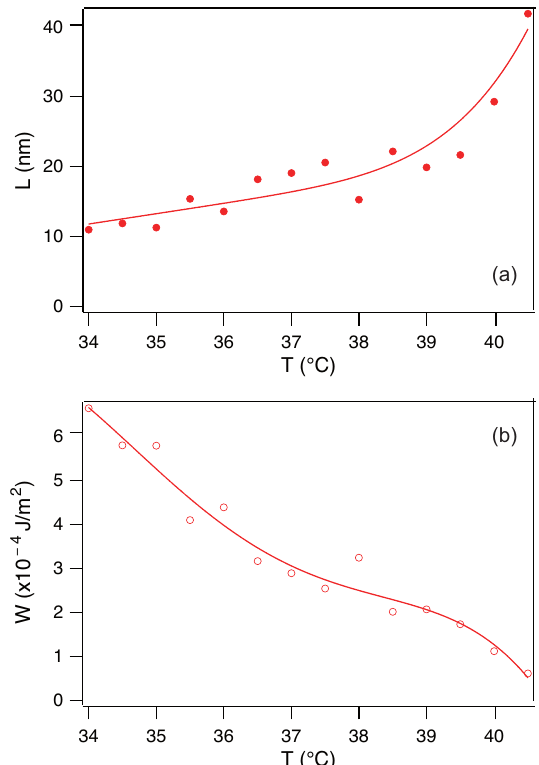
Figure 11. ( a ) Values of L obtained from the fit of the capacitance curves shown in Figure 7 by taking into account the electric field variation of ε (cid:107) . ( b ) Corresponding values of W . Solid lines are just guides for the